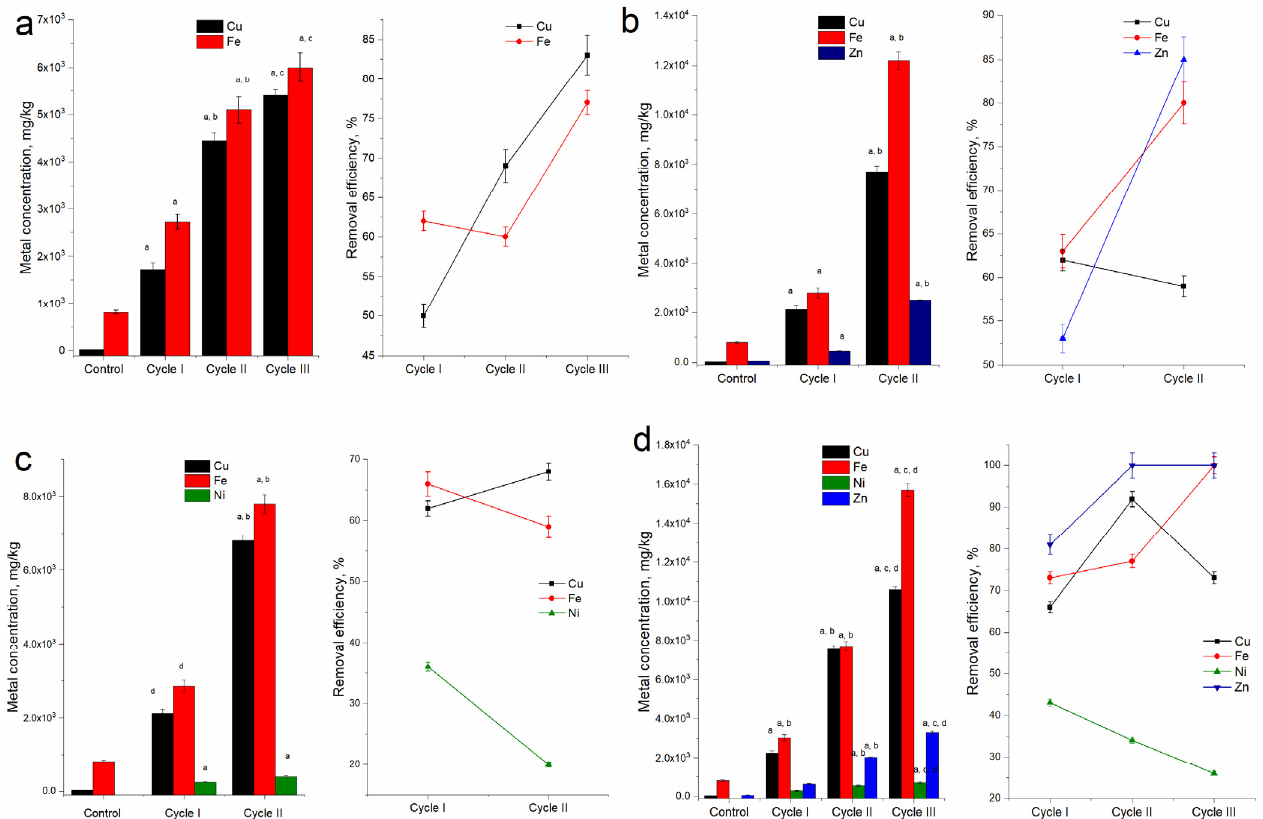
Figure 3. Bioaccumulation of copper and other metals by Nostoc linckia biomass during three life cycles in media containing multimetallic systems ( a ) Cu/Fe, ( b ) Cu/Fe/Zn, ( c ) Cu/Fe/Ni and ( d ) Cu/Fe/Ni/Zn (a— p < 0.001 for the difference between experimental and control samples, b— p < 0.001 for the difference between the first and second cycle, c— p < 0.001 for the difference between the first and third cycles, and d— p < 0.001 for the difference between the second and third cycles) .